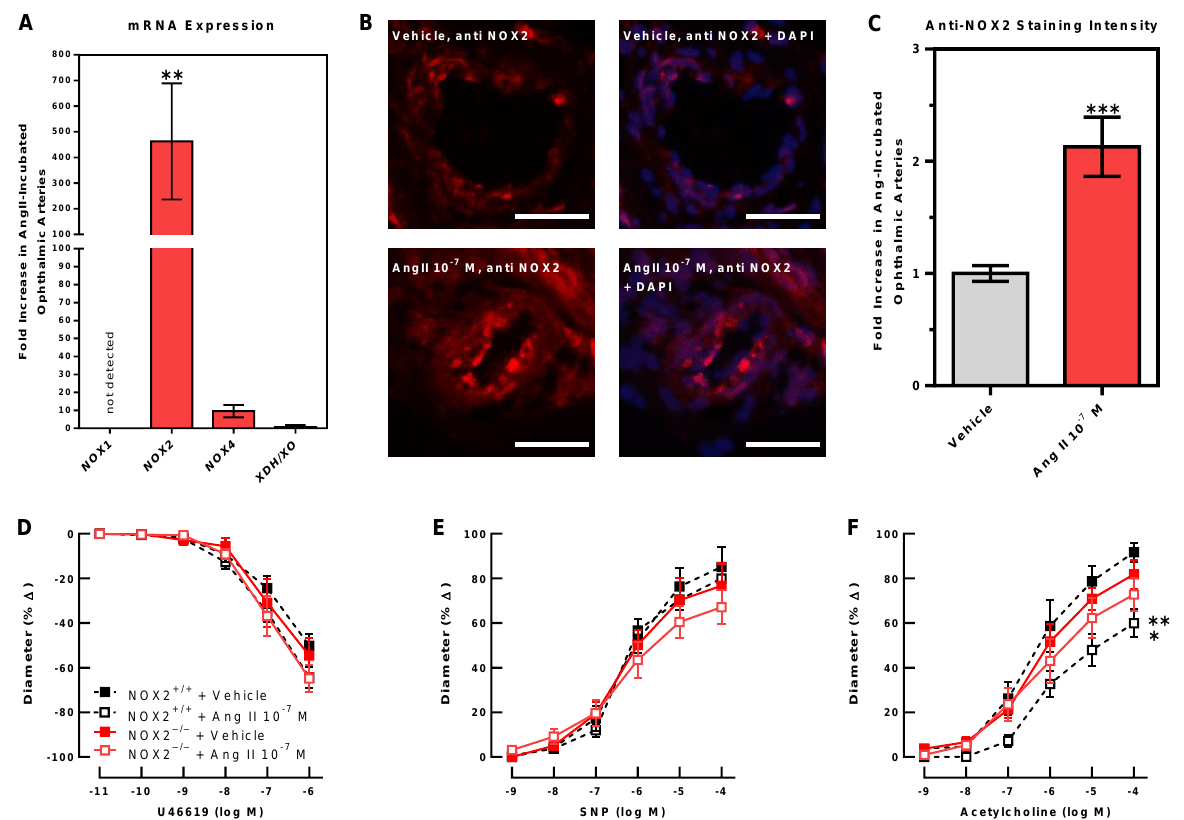
Figure 4. Incubation with Ang II (10 −7 M) induced marked expression of NOX2 mRNA in isolated ophthalmic arteries of C57Bl/6J mice. In contrast, NOX1 mRNA was undetectable, and NOX4 and XDH / XO mRNA only insignificantly increased in Ang II-incubated arteries compared to vehicle-incubated arteries ( A ) ( n = 6 per group, ** p < 0.01 versus vehicle control). While immunoreactivity to NOX2 was only weak in vehicle-incubated ophthalmic arteries from C57Bl/6J mice ( B , C ), much stronger immunoreactivity to NOX2 was seen in the vascular wall of arteries incubated with Ang II 10 −7 M ( B , C ) ( n = 8 per group, *** p < 0.001, Ang 10 −7 M versus vehicle control). Vasoconstrictor responses to U46619 ( D ), endothelium-independent vasodilation to SNP ( E ), and endothelium-dependent vasodilation to acetylcholine ( F ) were not reduced in isolated ophthalmic arteries from NOX2 – / – mice exposed to Ang II 10 −7 M compared to vehicle, suggesting that Ang II failed to induce endothelial dysfunction when NOX2 was not present. The curves with dashed lines were reproduced from Figures 1D – F for the direct comparison with the respective control condition. Data are expressed as mean ± SE ( n = 8 per group; ** p < 0.01, NOX2 +/+ + Ang II 10 −7 M versus NOX2 +/+ + vehicle; * p < 0.05, NOX2 +/+ + Ang II 10 −7 M versus NOX2 – / – + vehicle). Scale bar = 50 µm.